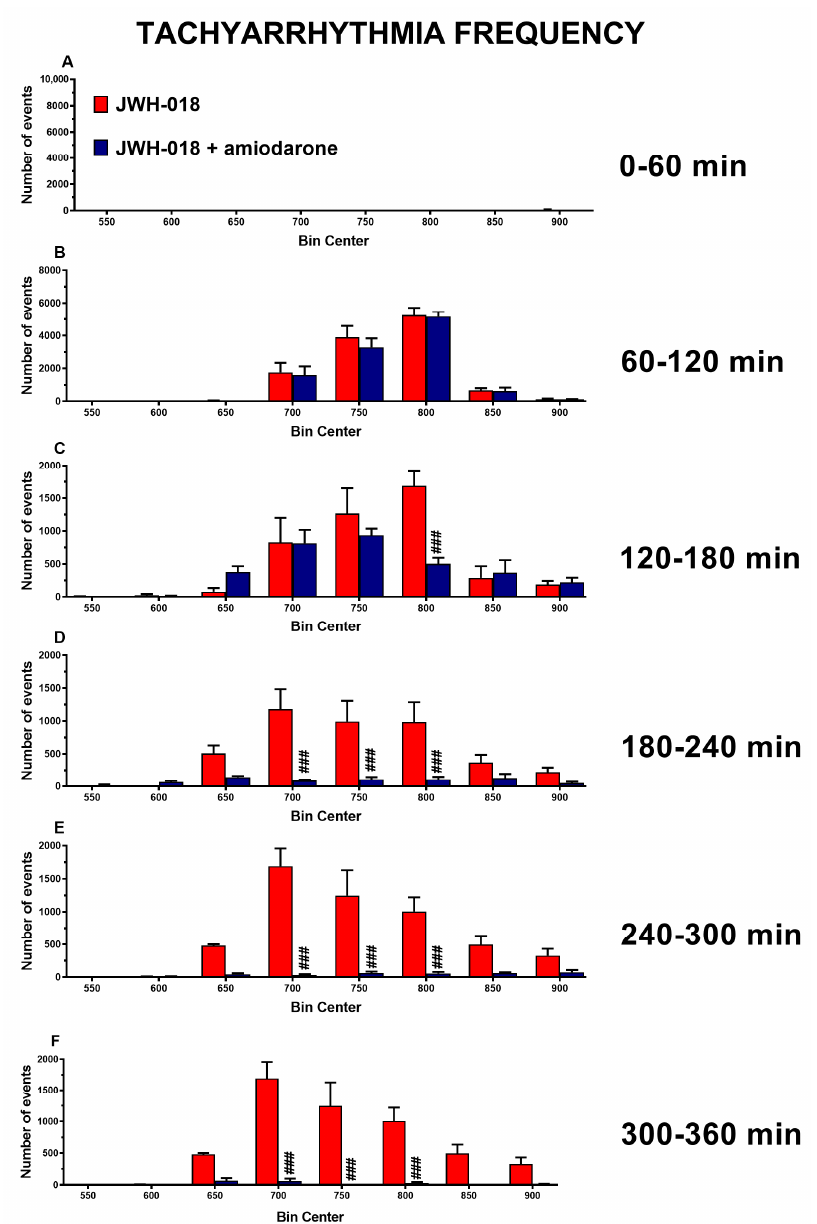
Figure 2. Frequency of tachyarrhythmia episodes between 0–60 ( A ), 60–120 ( B ), 120–180 ( C ), 180–240 ( D ), 240–300 ( E ), and 300–360 ( F ) minutes after administration of JWH-018 (6 mg/kg) or JWH-018 followed by amiodarone (5 mg/kg), expressed as number of events per mean heart rate value. Mean ± SEM of eight different evaluations for each group. Statistical analysis was performed by two-way ANOVA followed by Bonferroni’s test for multiple comparisons. ### p < 0.001 versus JWH-018 + amiodarone.